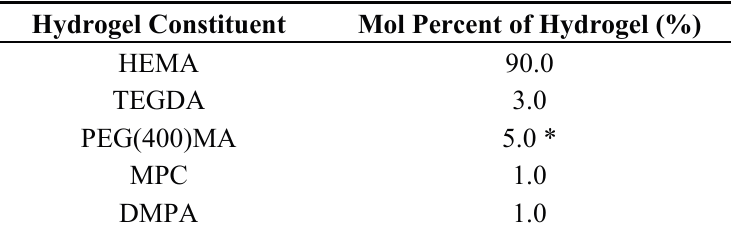
Table 2. Hydrogel composition.